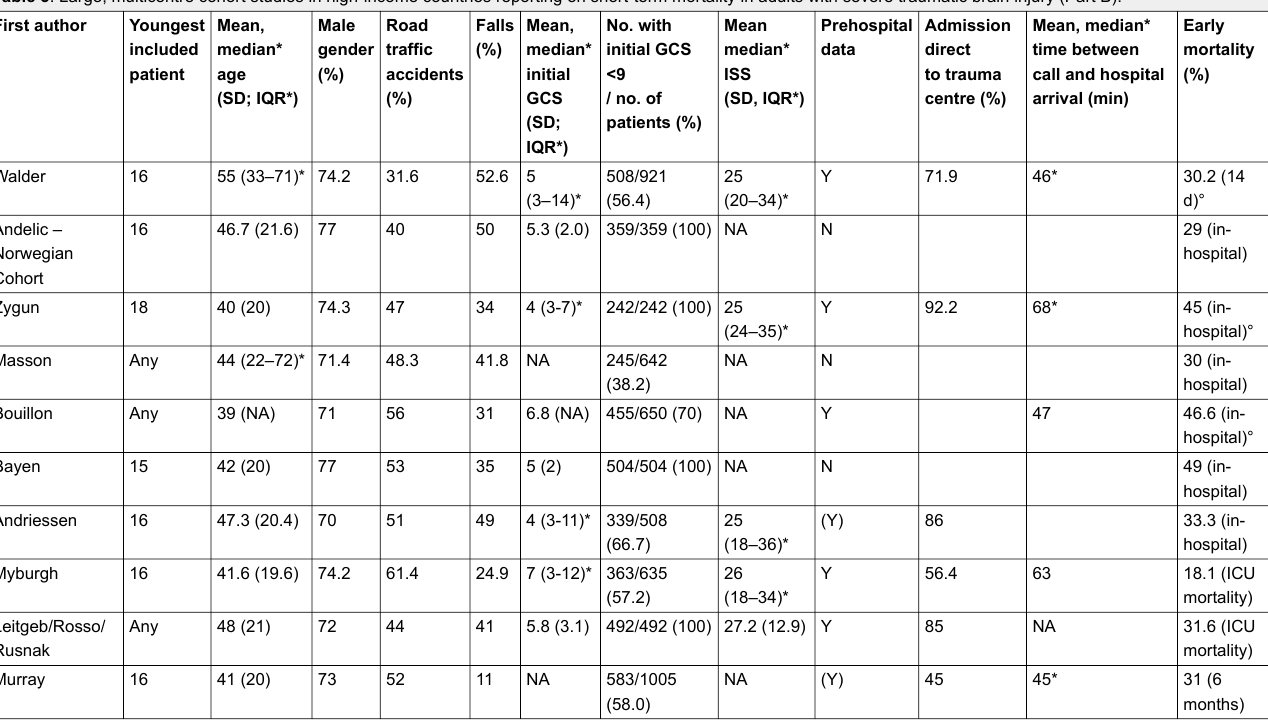
Table 3 : Large, multicentre cohort studies in high-income countries reporting on short-term mortality in adults with severe traumatic brain injury (Part